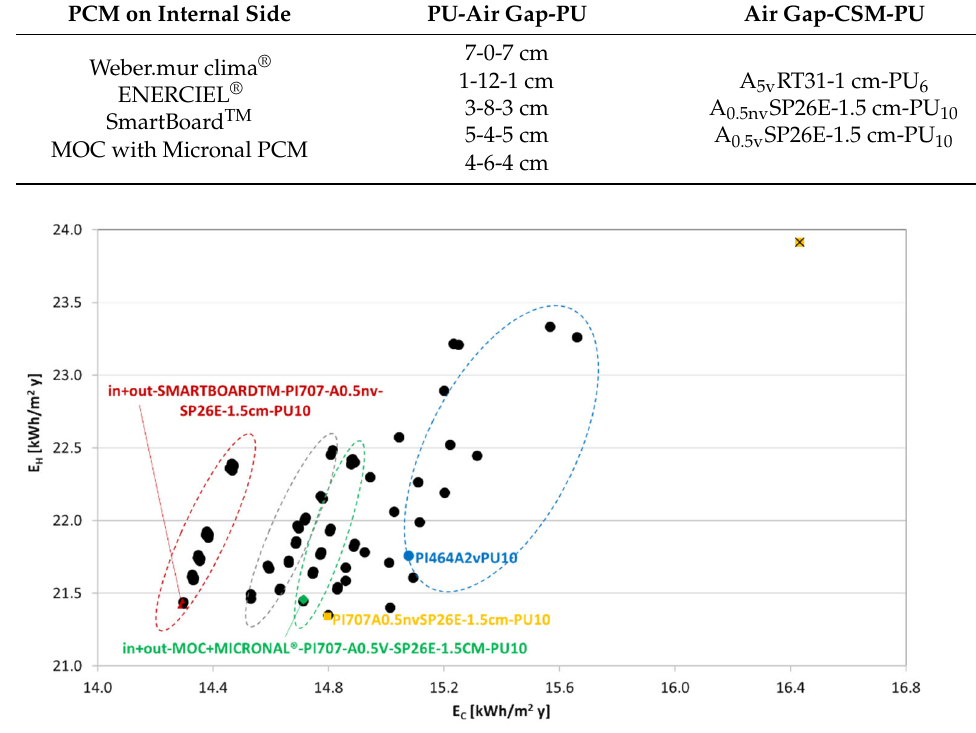
Figure 10. PCMs on both sides: comparison based on heating and cooling load.